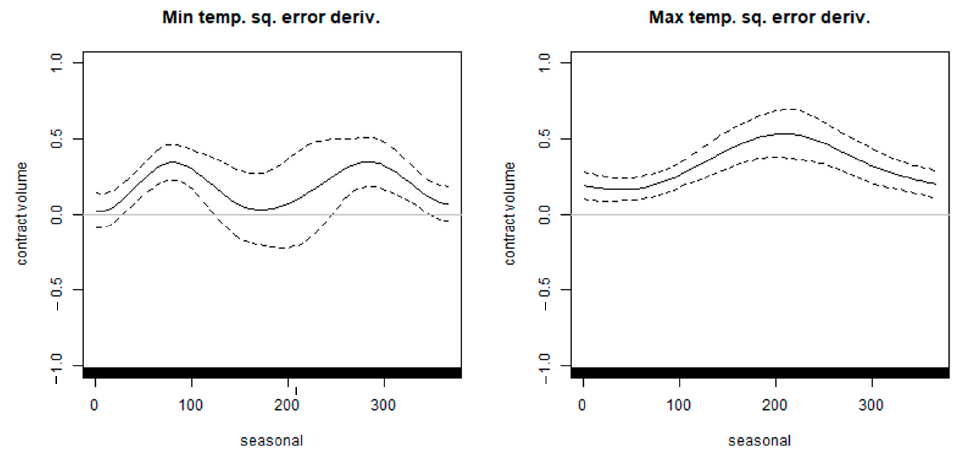
Figure 8. Estimated contract volume of the temperature squared error derivatives in the demand model (13).